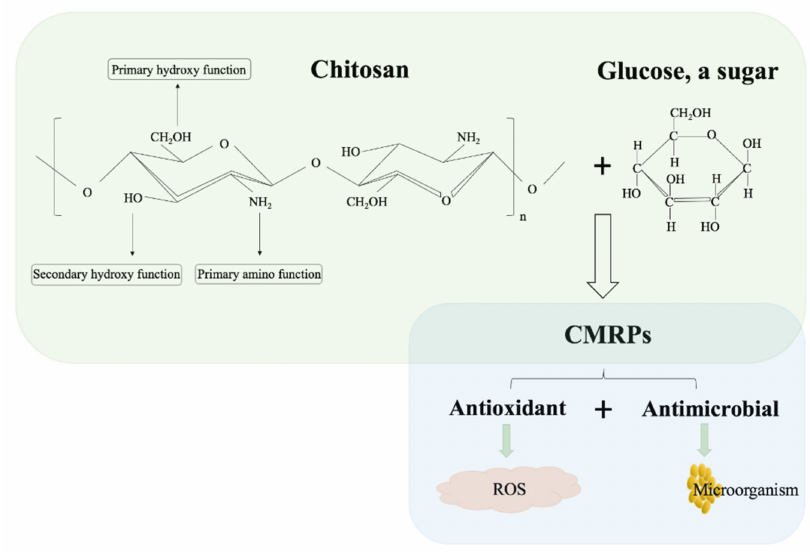
Figure 1. The chemical structure of chitosan and properties of CMRPs